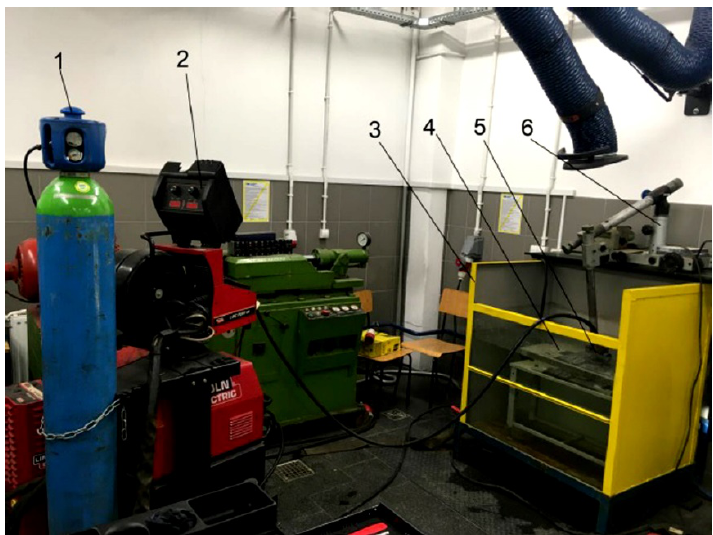
Figure 1. Welding test stand: 1-gas cylinder, 2-welding power source and wire feed unit, 3-tank, 4-welding table, 5-specimen, 6-welding trolley (tractor).